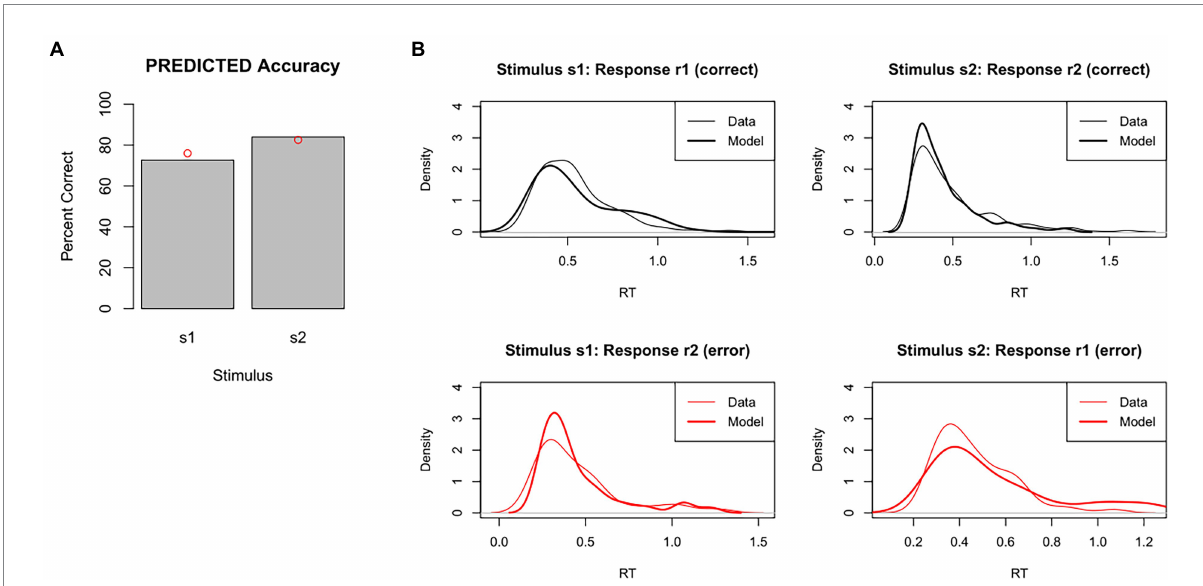
FIGURE 6 Results of model-fitting using maximum likelihood estimation (MLE). The set of DDM parameter values is identified that, together, maximizes the likelihood of the model producing same response as the participant on each trial. Given these “best-fitting” parameters, (A) accuracy levels for s1 and s2 in the predicted data were quite similar to those of the empirical data (red dots), and (B) RT distributions for each combination of stimulus and response were also quite similar in predicted and empirical data. DDM results obtained using RWiener package in